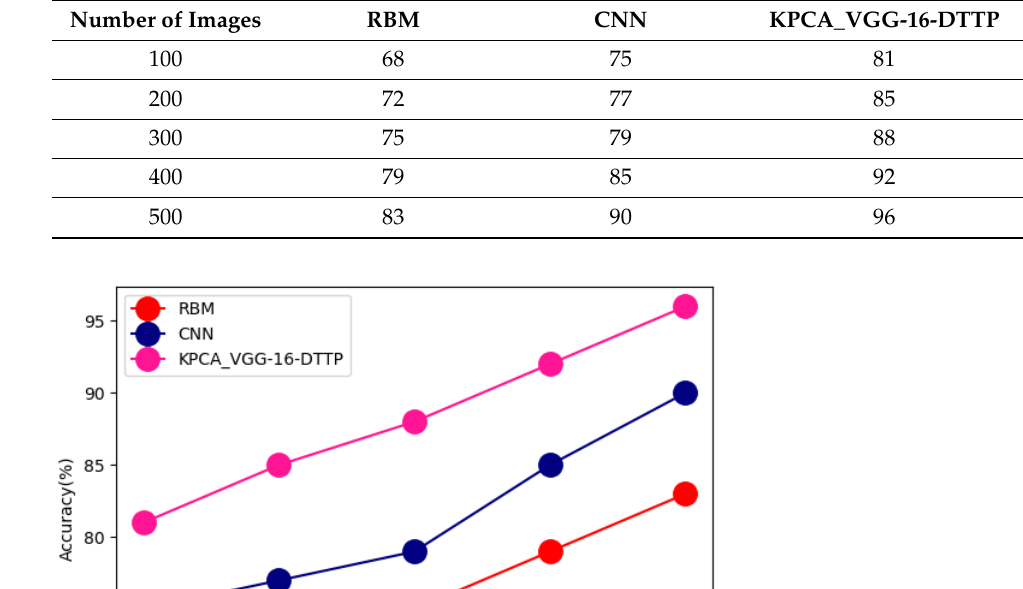
Table 1. Comparative analysis of accuracy.